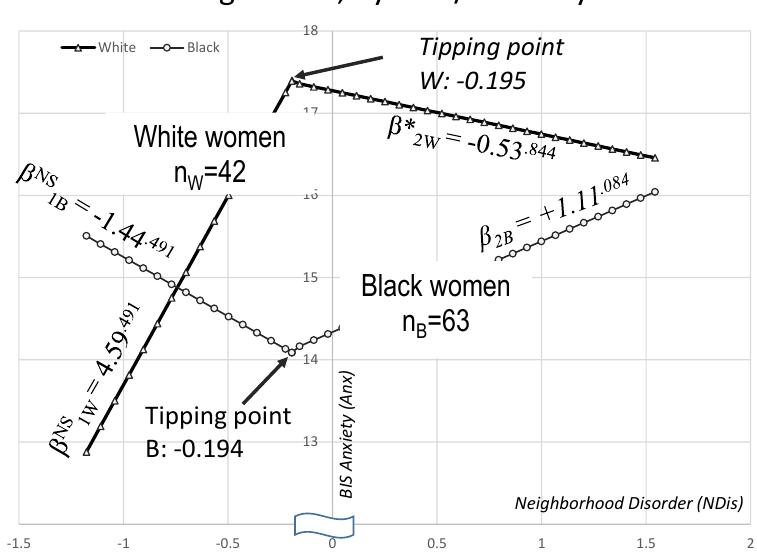
Figure 1. Linear slopes for neighborhood disorder → anxiety effects, shifting around similar tipping points.